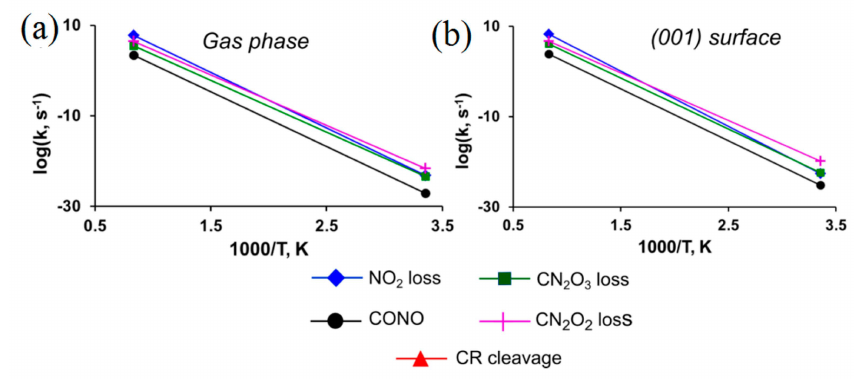
Figure 16. Reaction rates of BNFF decomposition ( a ) in the gas phase and ( b ) on (001)